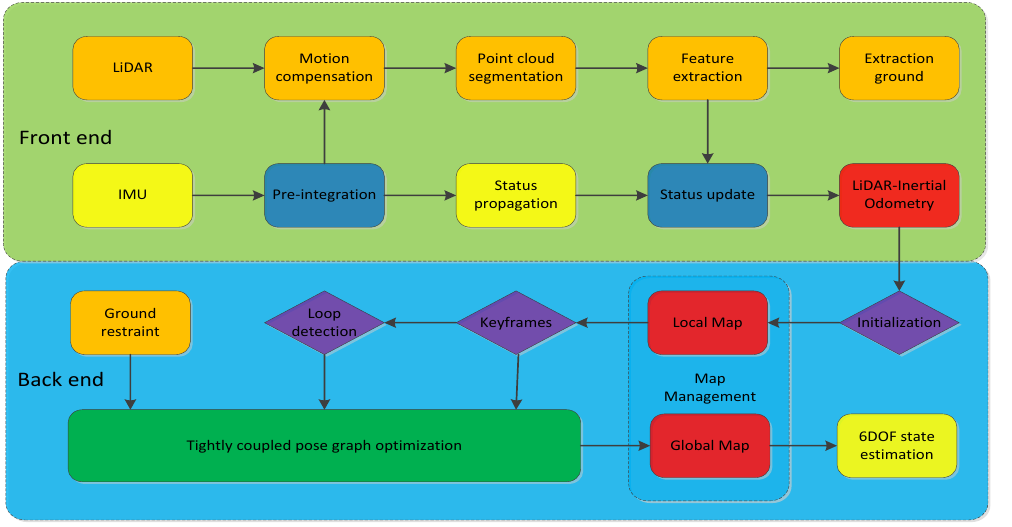
Figure 1. System framework.